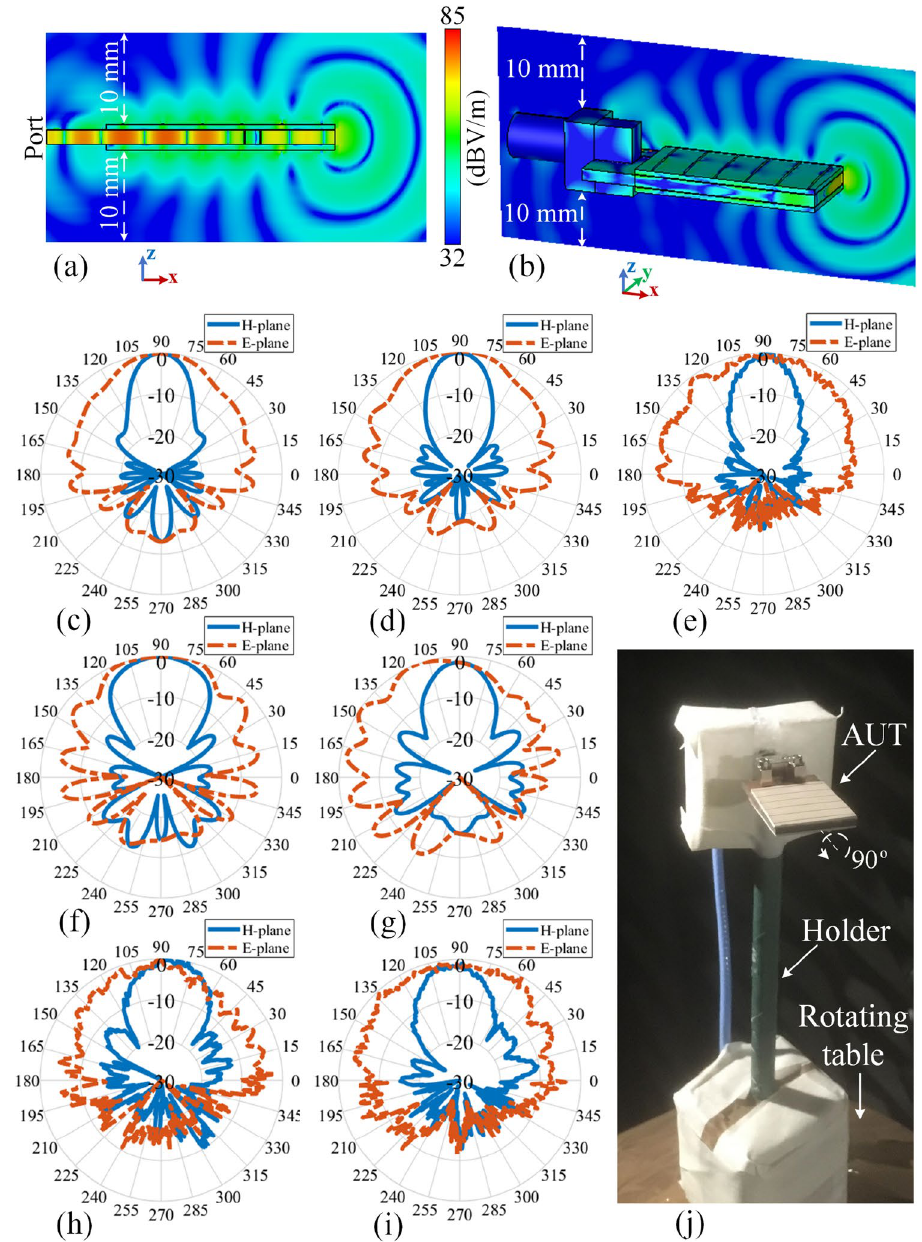
Figure 14. Performance of the final assembled prototype. The simulated |E-filed| distribution pattern at 30 GHz on the xz plane cut which is crossing the middle of the structure for the case of ( a ) without and ( b ) with the connector. The normalized radiation pattern at 30 GHz: ( c ) simulated without the connector, ( d ) simulated with the connector, ( e ) measured. The normalized simulated radiation pattern (with considering the connector) at ( f ) 29.5 GHz and ( g ) 30.5 GHz. The counterpart measured results at (h) 29.5 GHz and ( i ) 30.5 GHz. ( j ) The antenna under test (AUT) in an anechoic chamber (H-plane radiation pattern measurement).